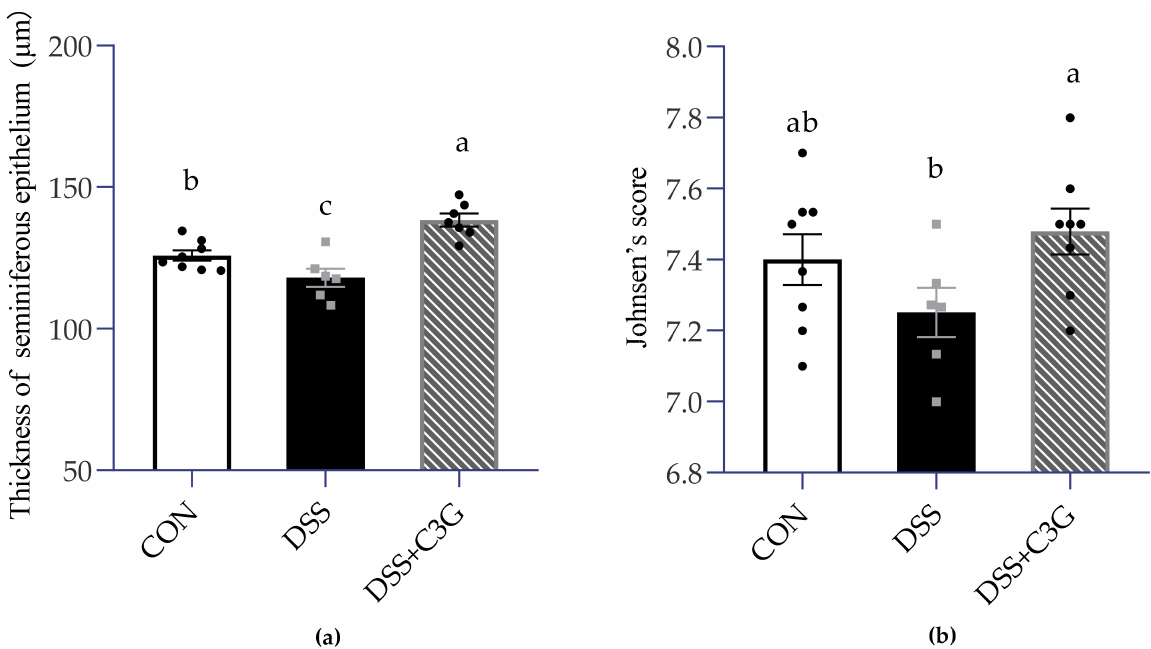
Figure 6. Impaired spermatogenesis in the DSS-induced mice. ( a ) Thickness of spermatogenic epithelium ( µ m). The thickness is obtained by subtracting the inner diameter from the outer diameter, n = 6–8. ( b ) Johnsen’s score of PAS-stained testis. • (cid:4) : The number of symbols was consistent with the number of samples, and the relative position represented the degree of data dispersion. Results were represented as mean ± SEM. Parameters marked by the same alphabet are not significantly different. Significance is expressed as p <